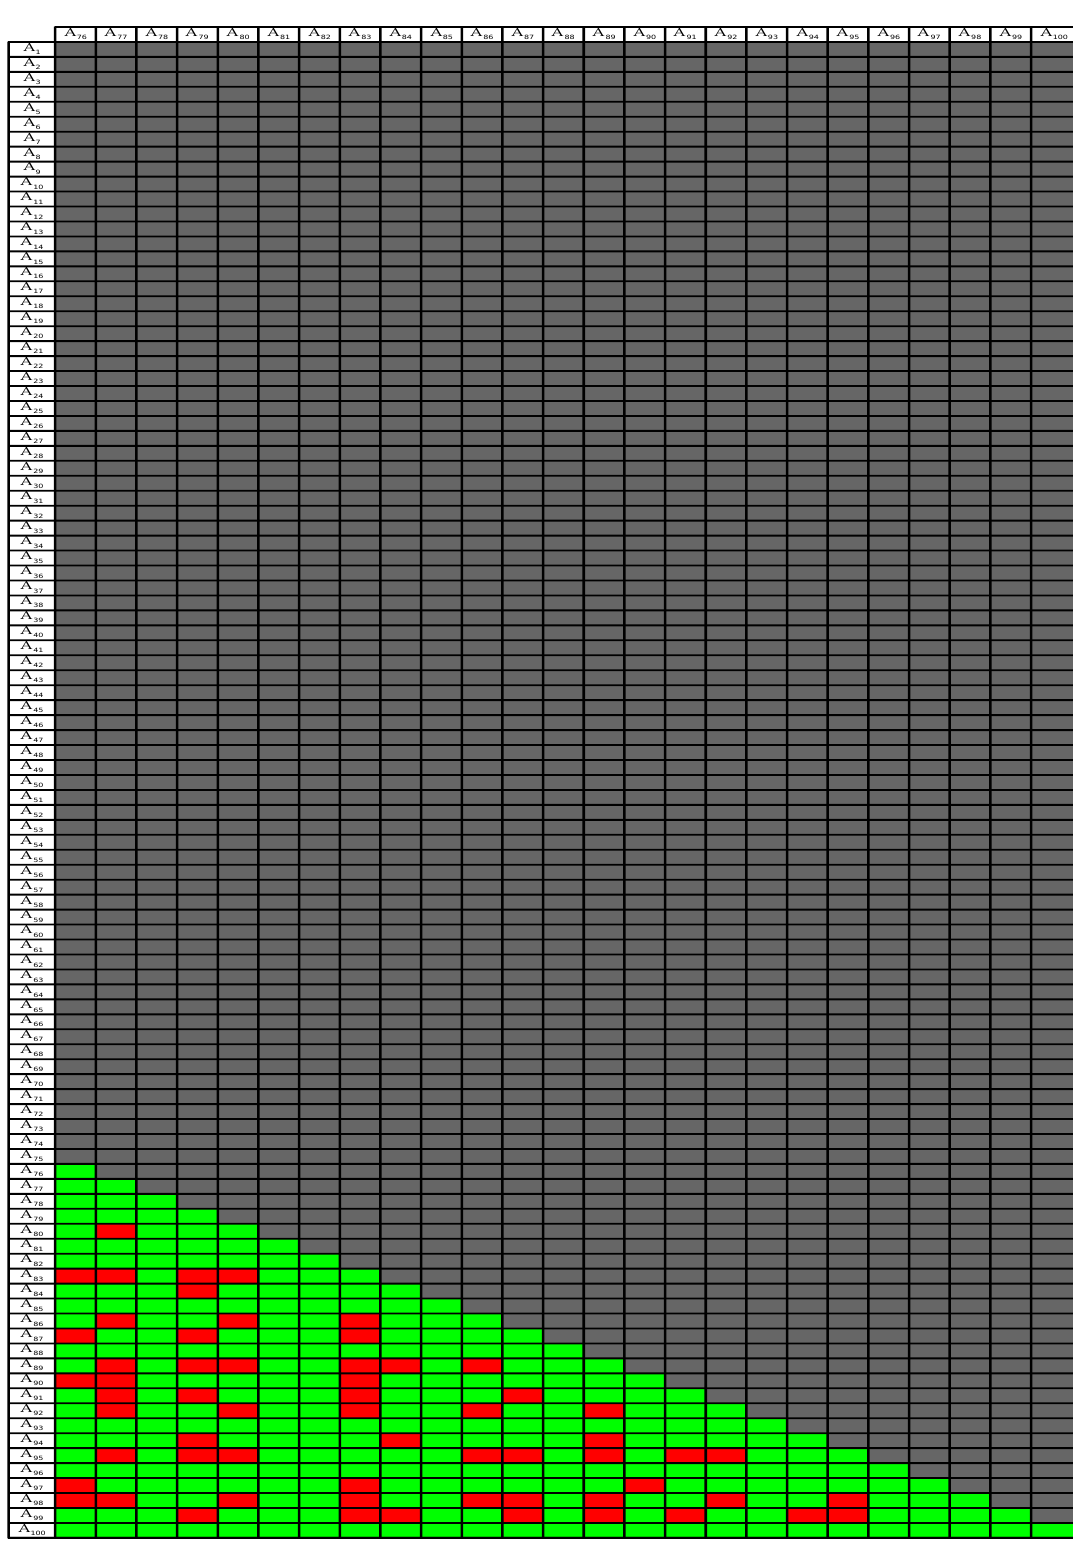
Table 5 . Analyzed theories for ( A n ; A m ) with n = 1 ; : : : 100 and m = 75 ; : : : 100.